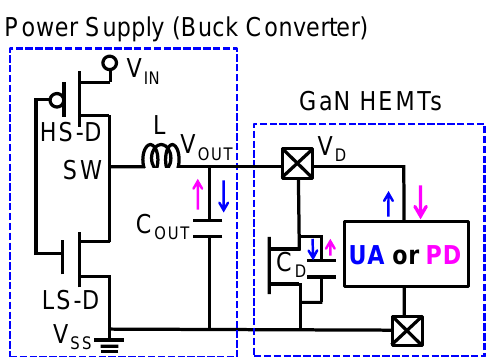
Figure 10. Unipolar arc (UA) model.